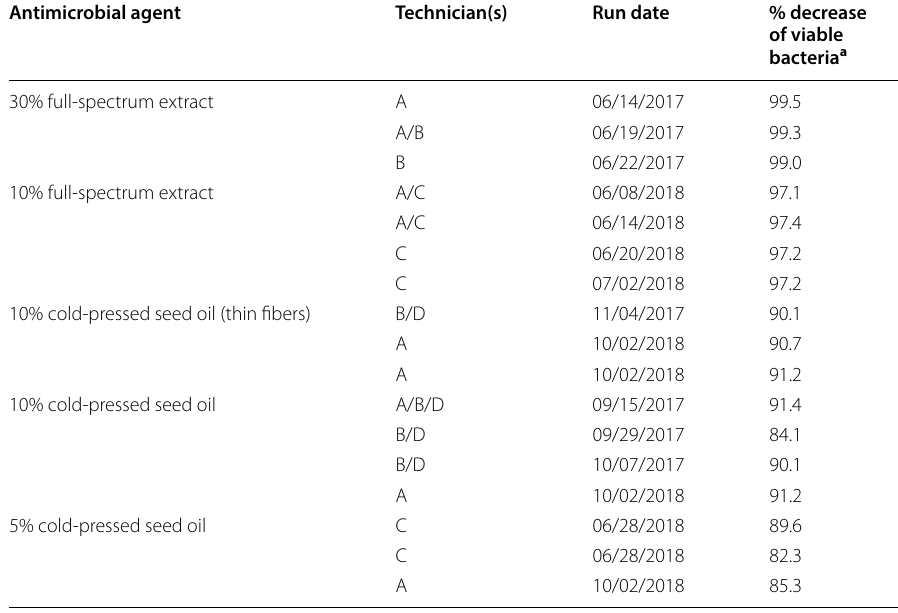
The test procedure yielded reproducible data on different days and across different technicians a The values shown are the percent decrease in viable bacteria recovered from the cold‑pressed hemp seed oil or full‑ spectrum hemp extract samples, as compared to the viable bacteria recovered from the paired acetate‑only samples run on the same day. All samples were on aluminum foil backing of the same type and thickness